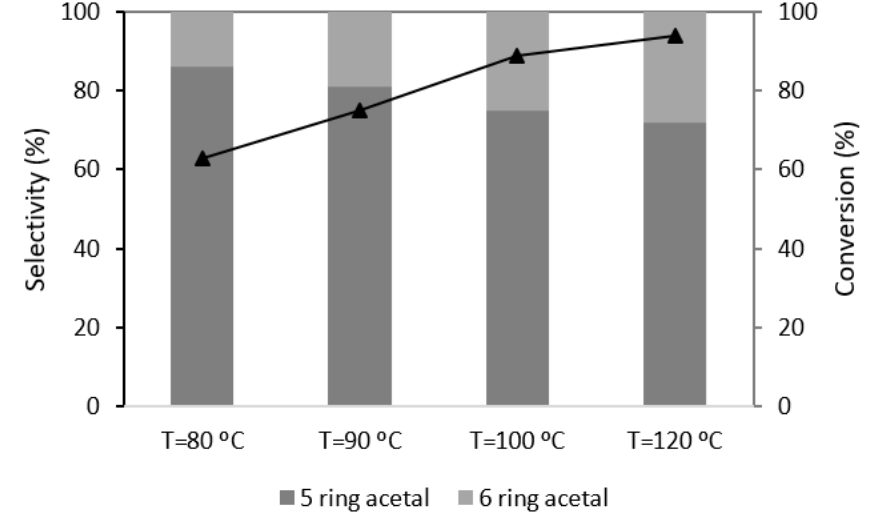
Figure 10. Acetalization of glycerol with citral over PW4-K-6. Effect of the